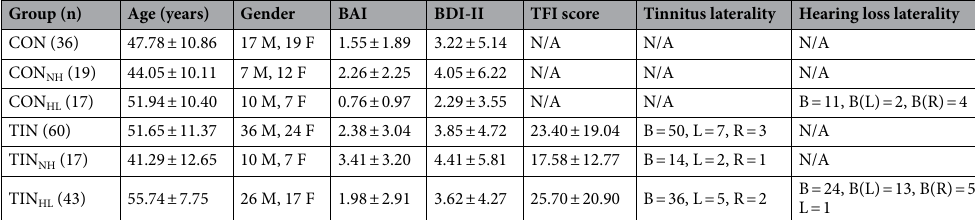
Table 4. Mean ± Standard Deviation for participant demographics. B bilateral, L left ear, R right ear, B(L) bilateral, asymmetric left, B(R) bilateral, asymmetric right.